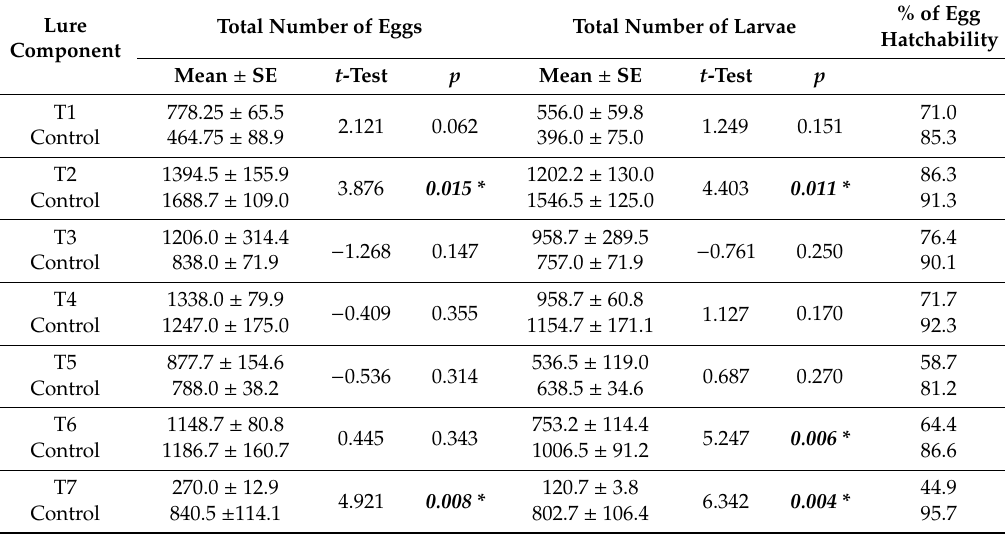
Table2. Mean( ± SE)numberof Marucavitrata eggs, hatchedlarvae, andpercentageofeggsthathatched from females exposed to seven different pheromone lures under laboratory conditions (scotophase period) (n = 16 females). T1 = (E, E)-10,12-hexadecadienal; T2 = (E, E)-10,12-hexadecadienol; T3 = (E)-10-hexadecenal; T4 = T1 + T2; T5 = T1 + T3; T6 = T2 + T3; T7 = T1 + T2 + T3. Total number of eggs, number of larvae, and hatchability from paired comparison experiment with four replicates, and four M. vitrata pairs per replicate.